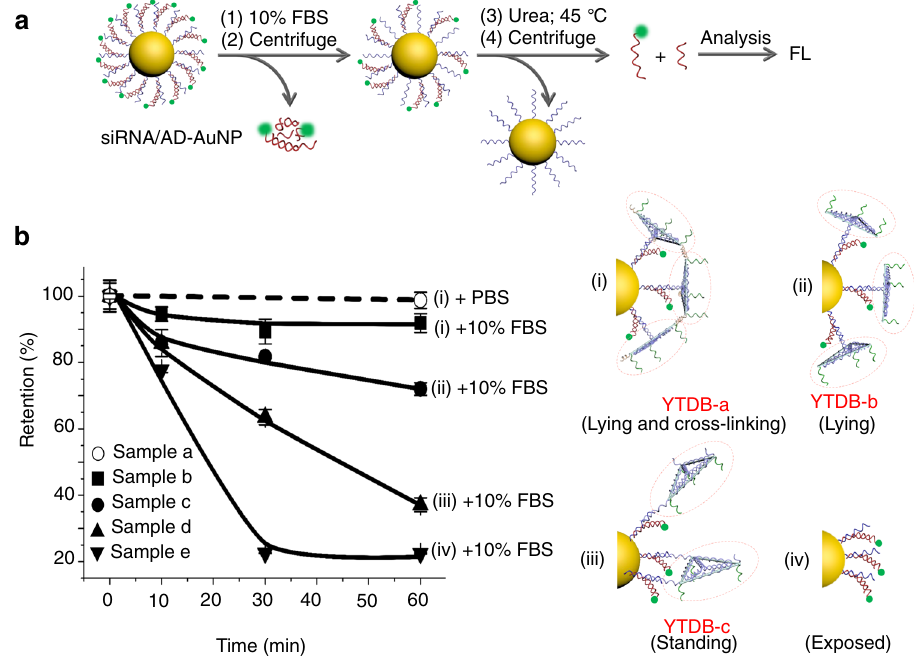
Fig. 3 The fl uorescently measured data in homogenous solution to demonstrate the FBS stability of siRNA/Ap-CS formulation, where siRNA was FAM-modi fi ed siLuc. a Schematic illustration of the method for evaluation of the AuNP-con fi ned siRNA stability. b Quantitative evaluation of the retention (%) of surface-con fi ned siRNAs after exposure of four different siRNA-encapsulated formulations (i – iv) to FBS, where the retention ef fi ciency of nontreated formulation corresponding to each group is de fi ned as 100%. Samples a-e represent the solutions of Nanoparticle-i + PBS, Nanoparticle-i + 10% FBS, Nanoparticle-ii + 10% FBS, Nanoparticle-iii + 10% FBS, and Nanoparticle-iv + 10% FBS, respectively. Nanoparticle-i is the siRNA/Ap-CS with